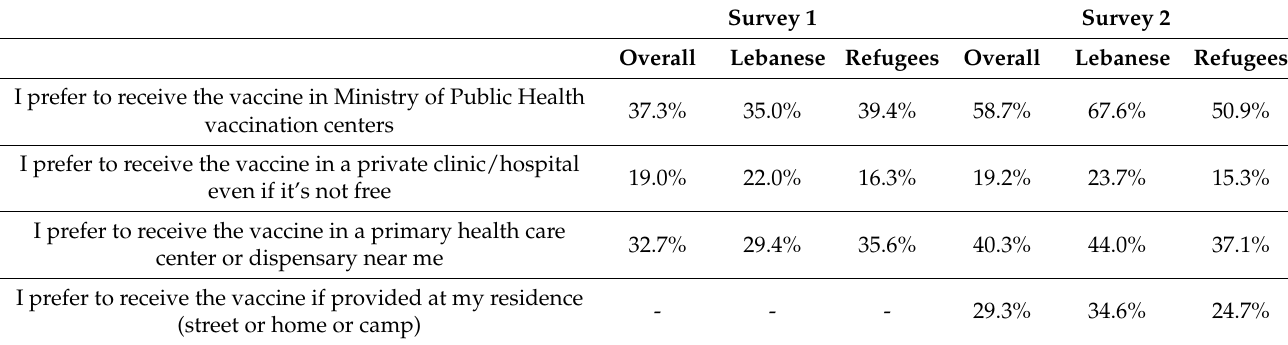
Table 4. Preference regarding vaccination sites among Lebanese nationals and